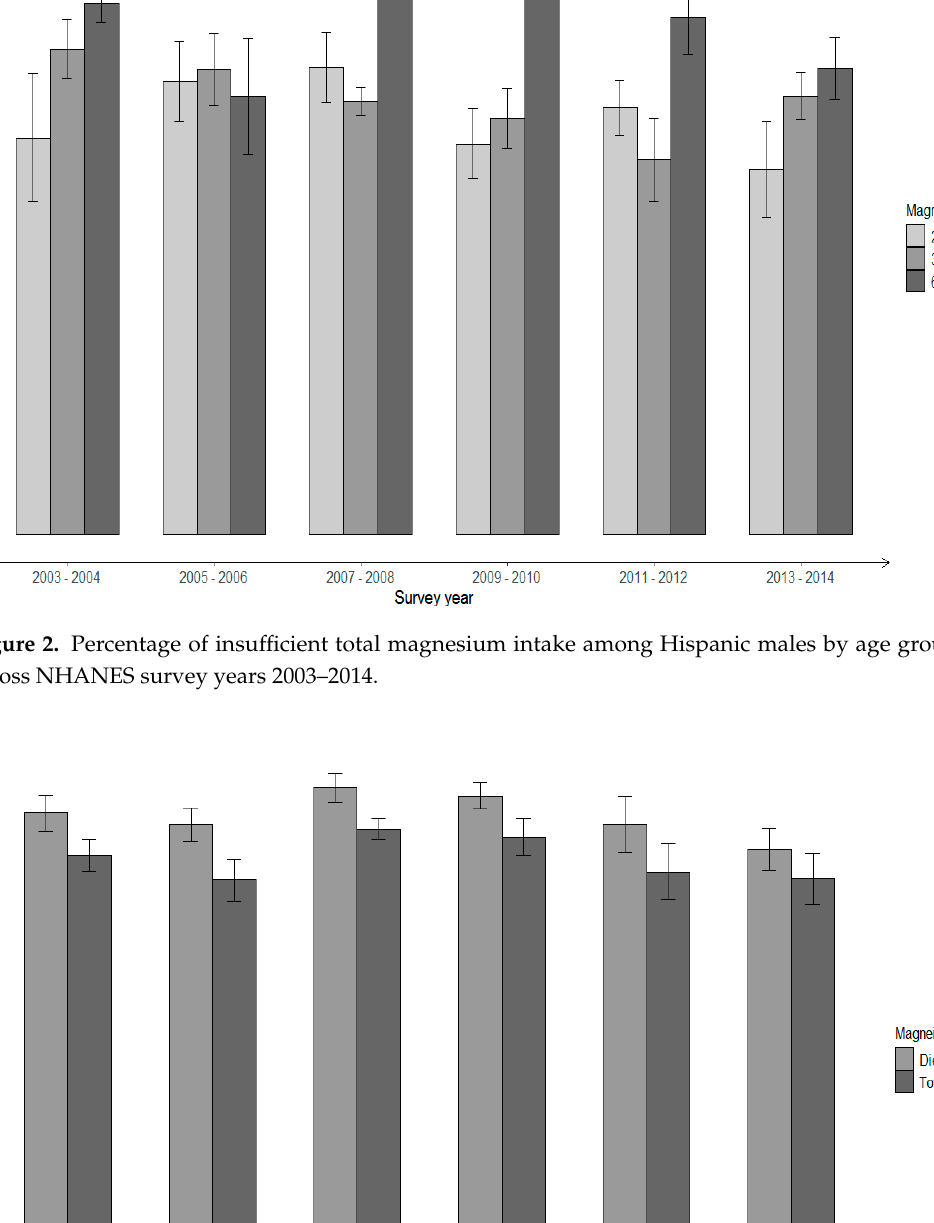
Figure 1. Percentage of insufficient dietary and total magnesium intake among Hispanic males aged ≥ 20 years across NHANES survey years 2003–2014.